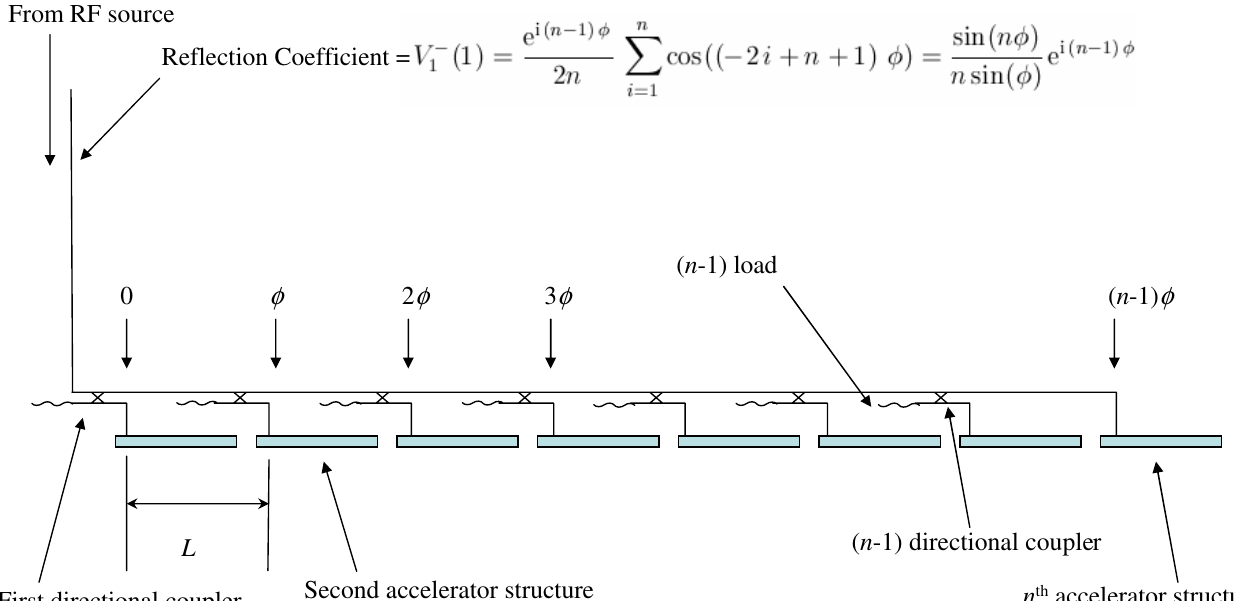
FIG. 1. (Color) A chain of directional couplers feeding a set of standing-wave accelerator